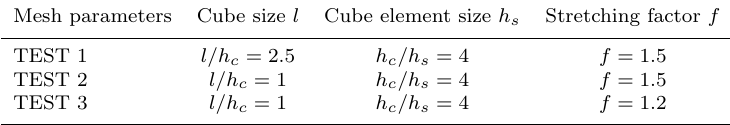
Focusing on quadratic elements, the corresponding errors decrease as L